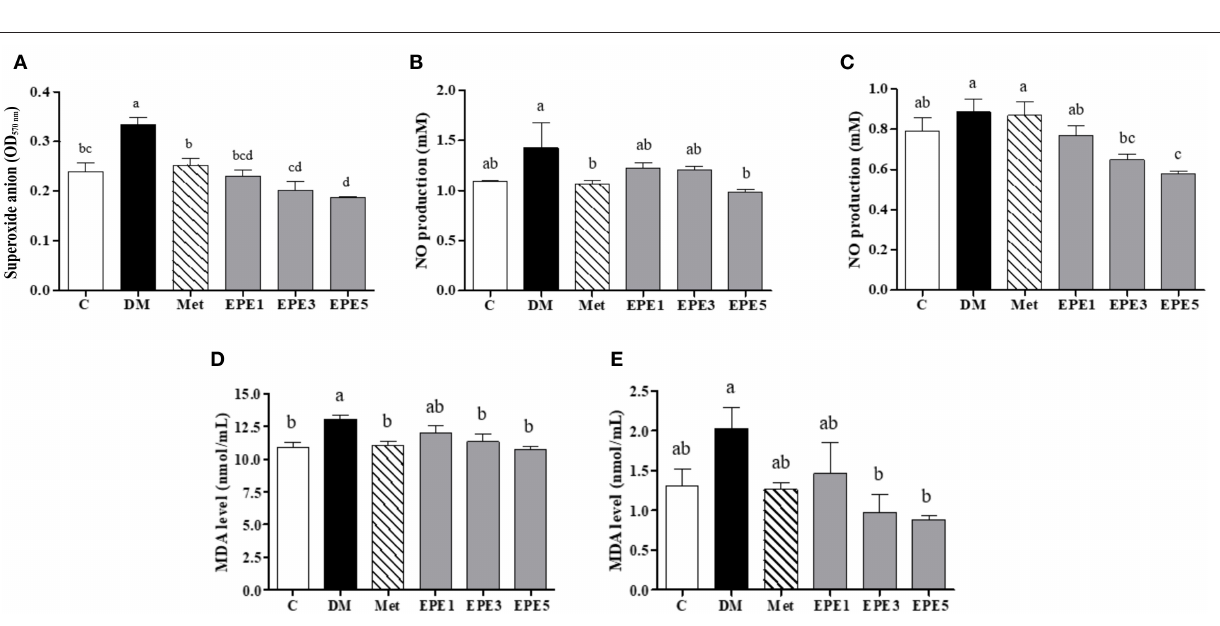
FIGURE 4 | The levels of (A) sperm superoxide anion, (B) plasma nitric oxide (NO), (C) sperm NO, (D) plasma malondialdehyde (MDA), and (E) sperm MDA in diabetic rats after 4 weeks of treatment. Data are shown as the mean ± SEM ( n = 6). The values with different superscript letters (a–d) represent significant differences ( p < 0.05) as analyzed by Duncan’s multiple range test. C, control; DM, diabetes mellitus; Met, metformin; EPE, Echinacea purpurea ethanol